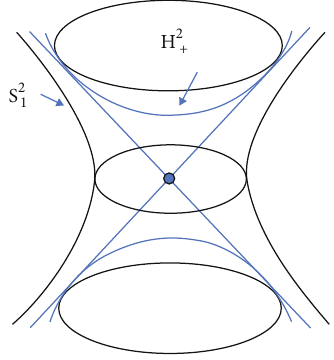
Figure 1: The hyperbolic and Lorentzian dual unit